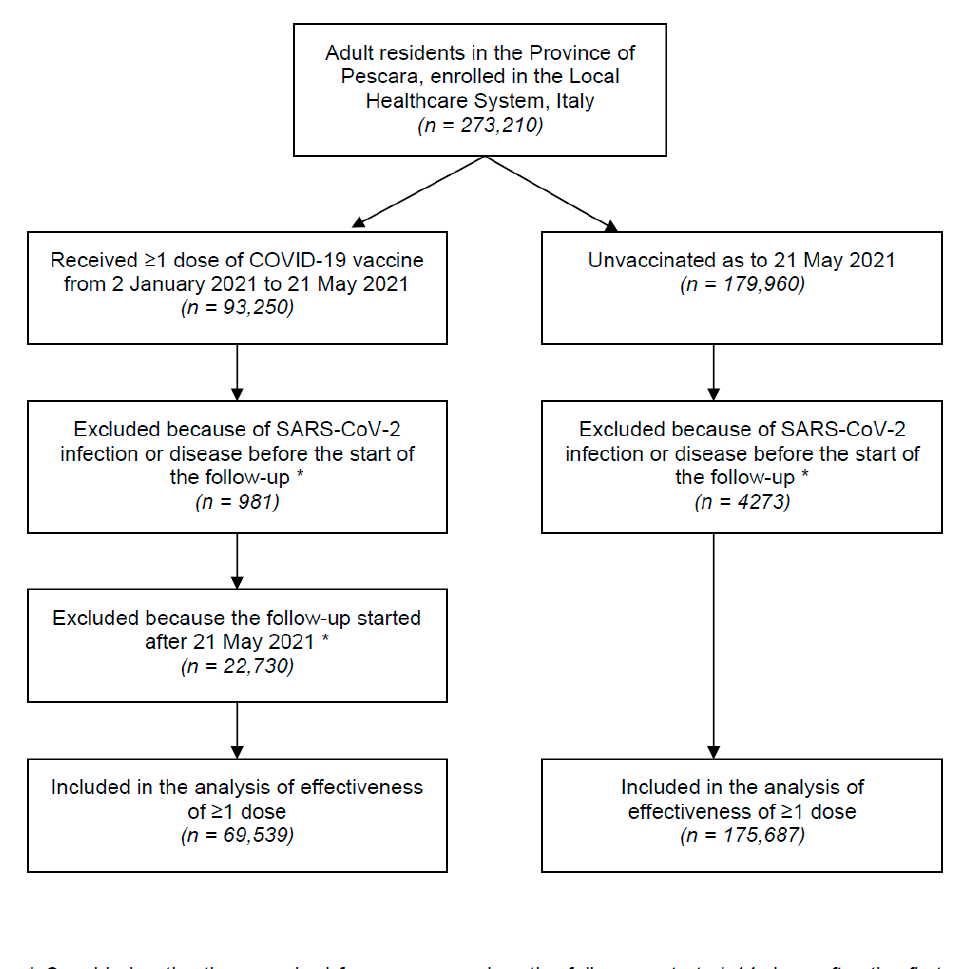
Figure 1. Flowchart of study participants.